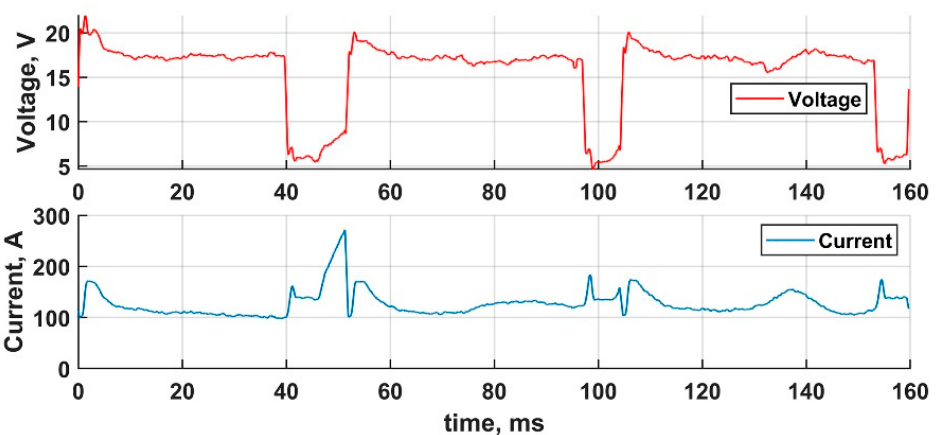
Figure 5. Three definitive CSC cycles.